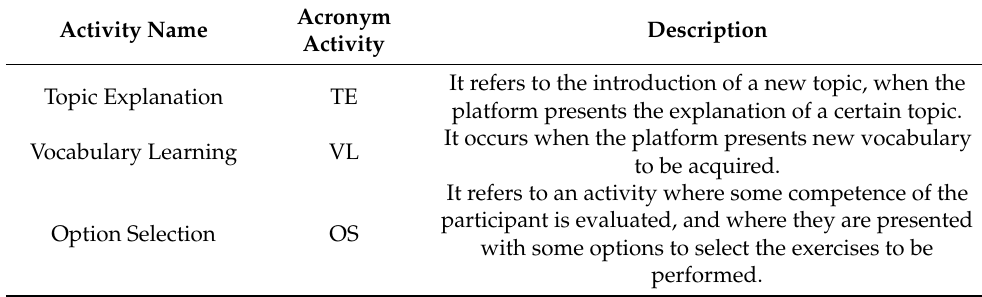
Table 1. Grouping and classification of activities.